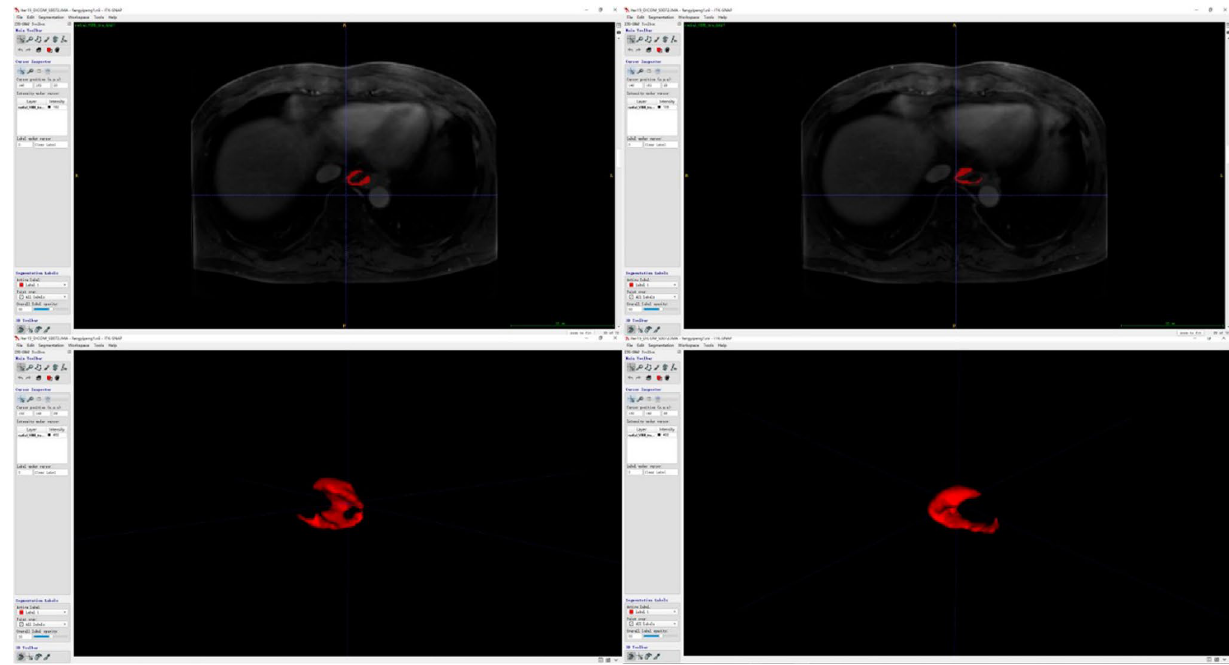
Fig. 6 Tumor Segmentation, and 3D tumors of pre-nCT were